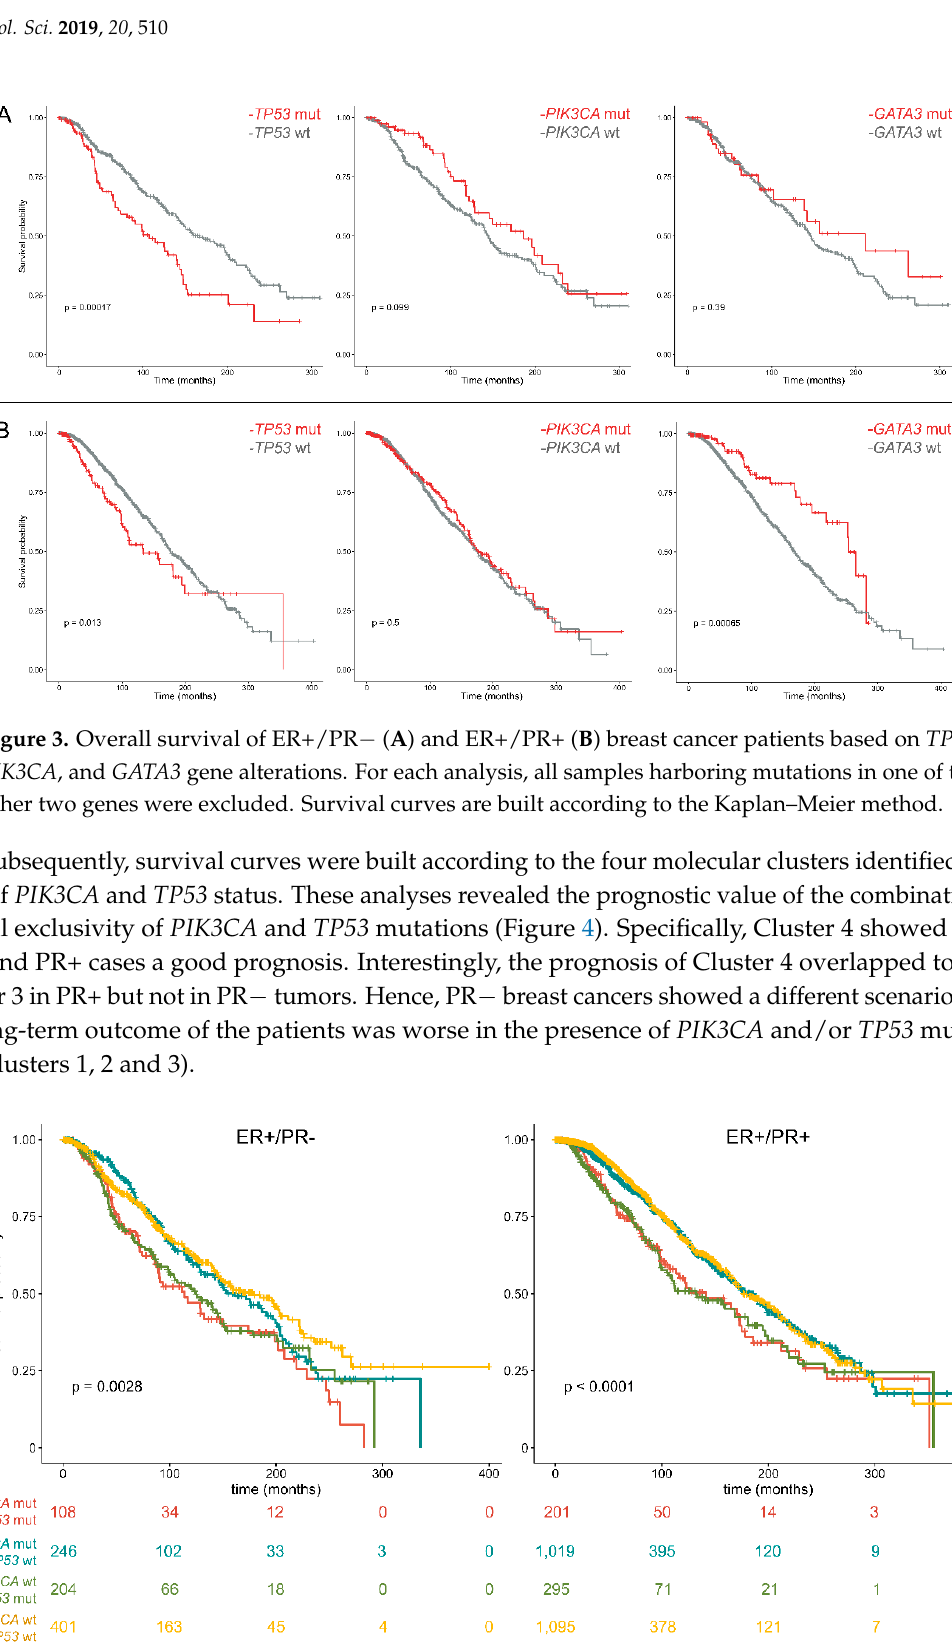
Figure 4. Overall survival of PIK3CA / TP53 -mutant (Cluster 1), PIK3CA mutant/ TP53 wild-type (Cluster 2), PIK3CA wild-type/ TP53 -mutant (Cluster 3), and PIK3CA / TP53 wild-type (Cluster 4) ER+ breast cancers, based on PR activation. Survival curves are built according to the Kaplan–Meier method.